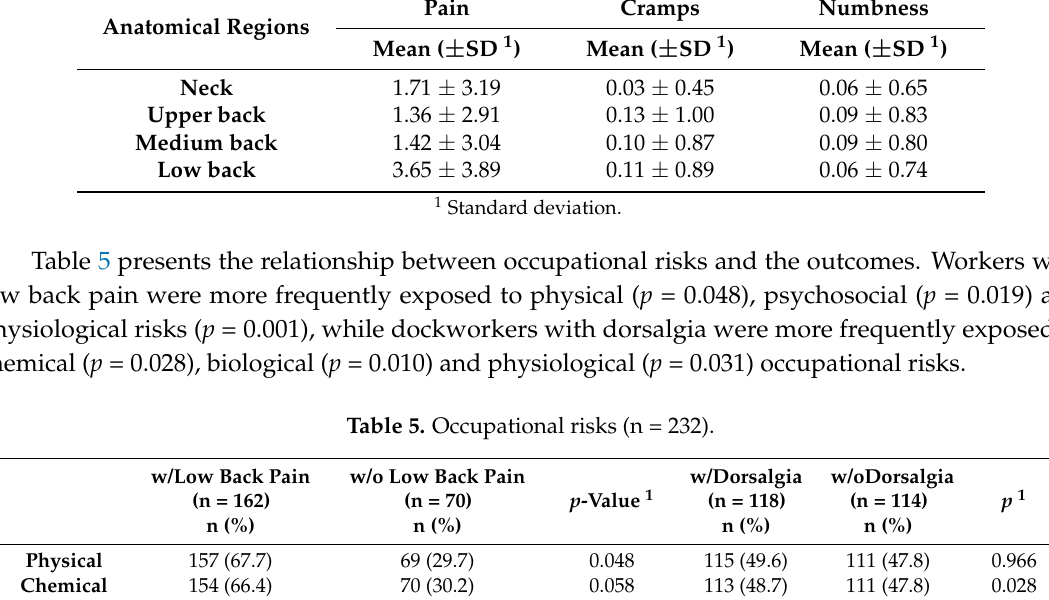
Table 4. Rates assigned by casual dockworkers for pain, cramps and numbness in anatomical regions. Pain Cramps Anatomical Regions